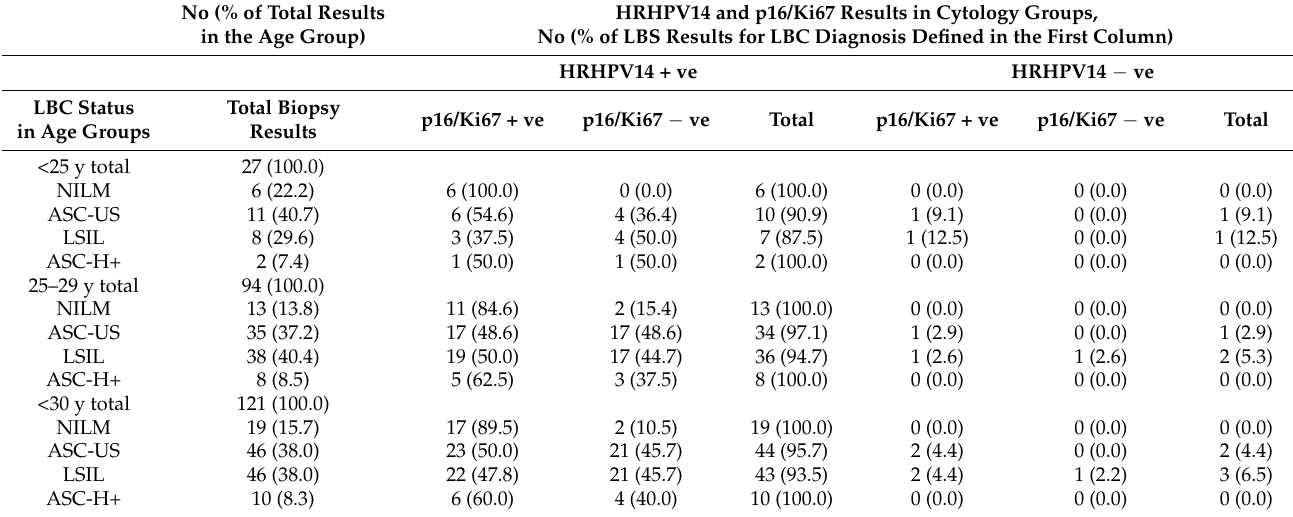
Table 9. Age-stratified (<25, 25–29 and <30 years) LBS results for cases with biopsy results.